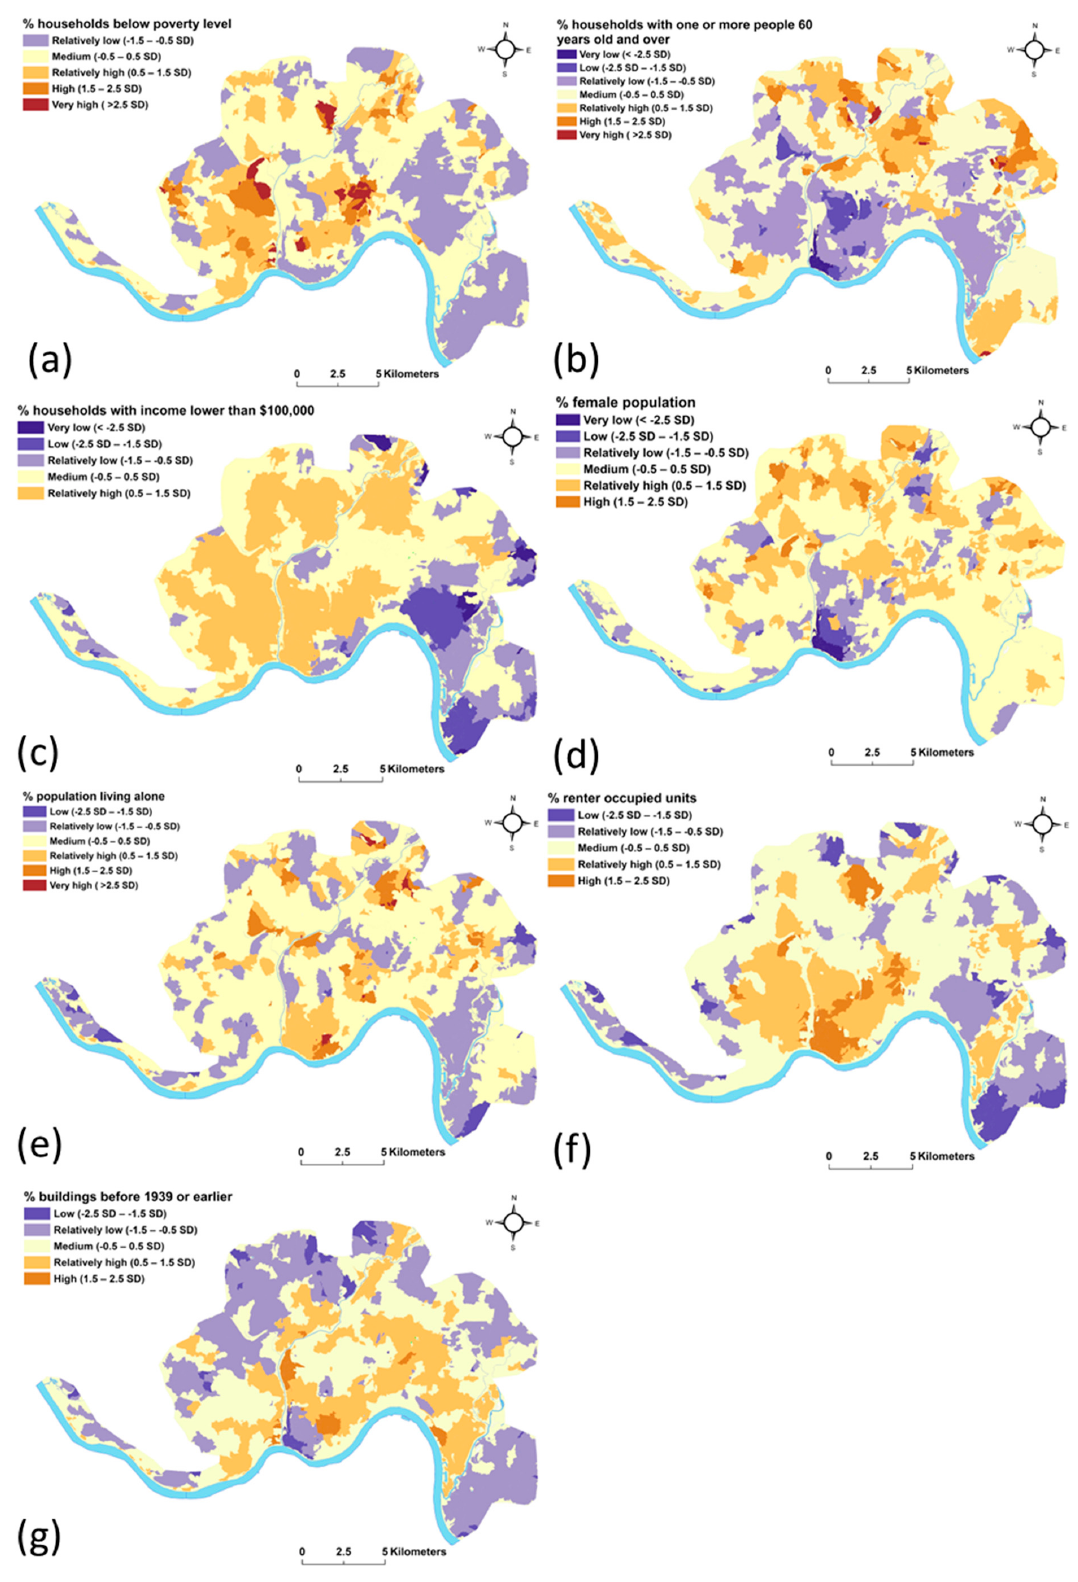
Figure 6. The results of individual social vulnerability indicators, ( a ) % households below poverty level, ( b ) % households with one or more people 60 years old and over, ( c ) % households with income lower than $100,000, ( d ) % female population, ( e ) % population living alone, ( f ) % renter occupied units, ( g ) % buildings before 1939 or